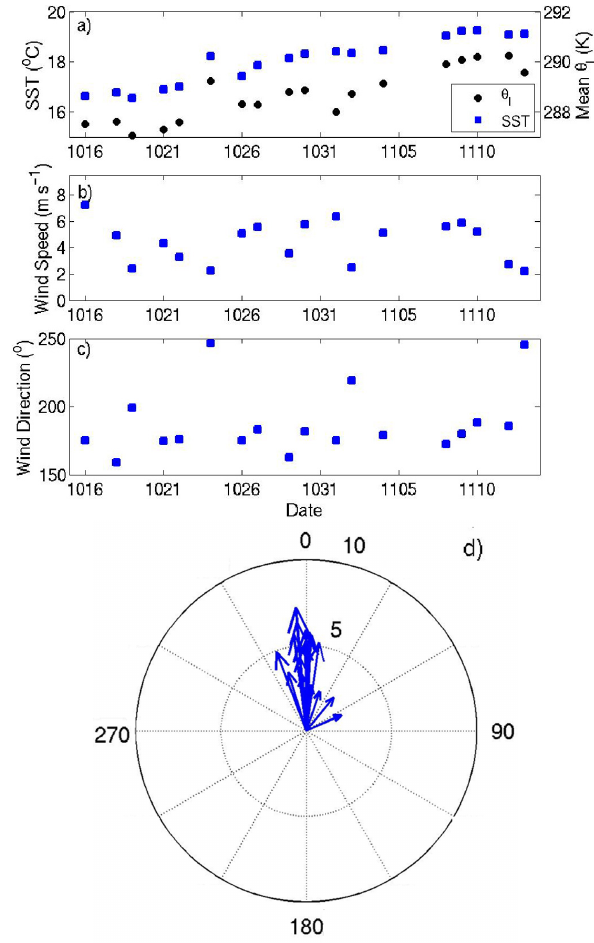
Fig. 12. (a) SST and BL-averaged θ l , (b) 30-m wind speed, (c) 30- m wind direction, and (d) surface wind vectors from flight